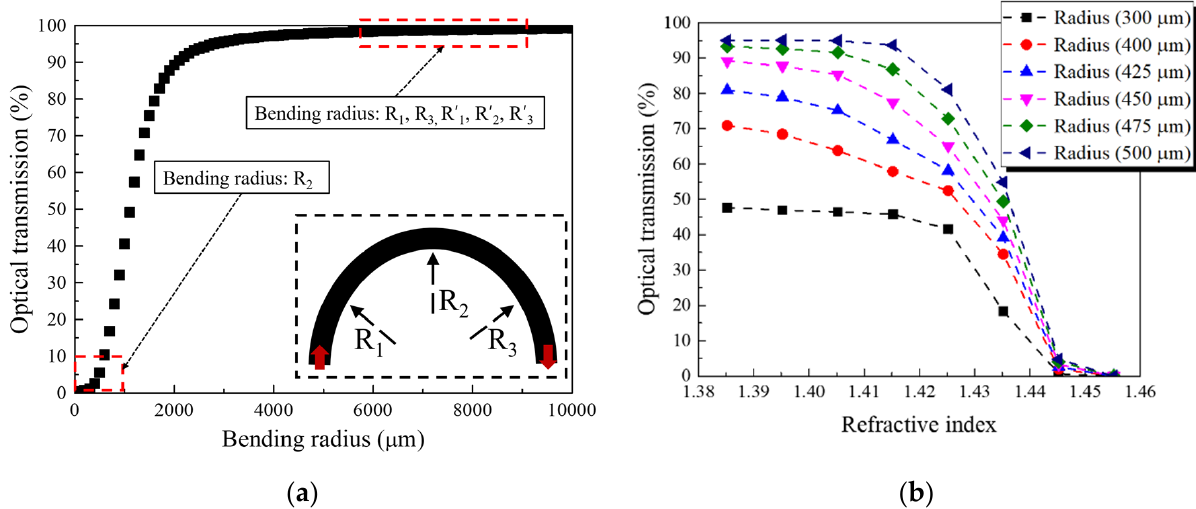
Figure 2. Optical characteristics (simulation results) of the bent waveguide, according to ( a ) bending radius (inset: connected C-bend structures of the U-shaped waveguide), and ( b ) variation in the refractive index (RI) of the trench.